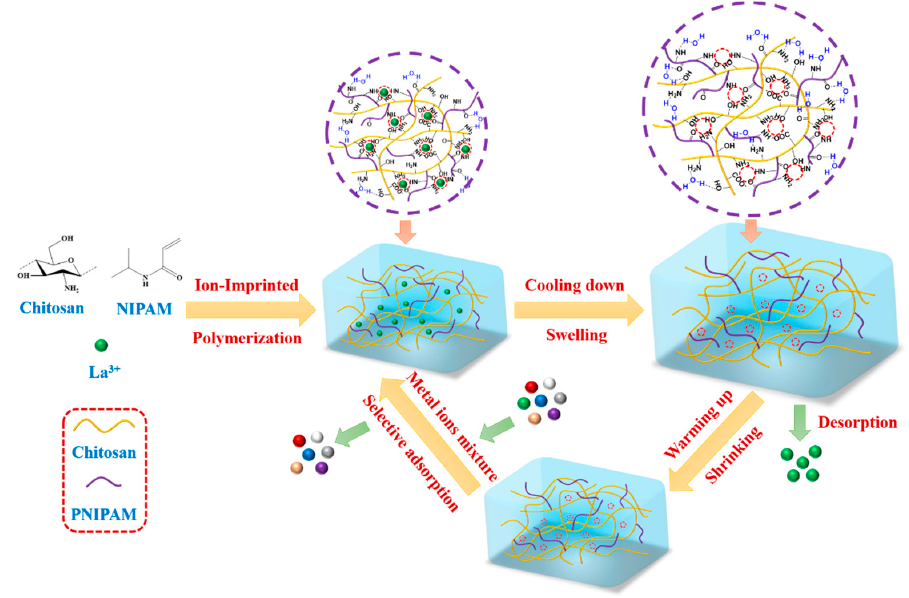
Figure 1. Preparation, adsorption and desorption process of CLIT.